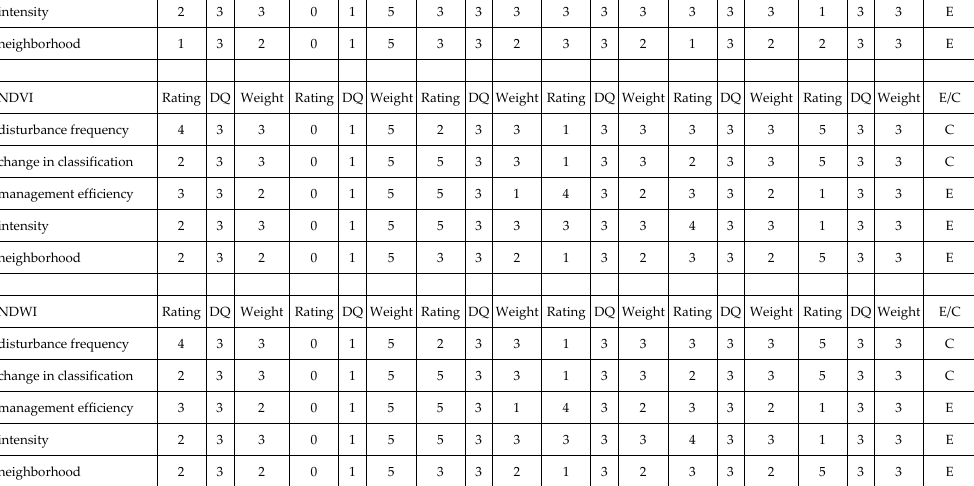
Figure A1. The Habitat Stressor Info Table.